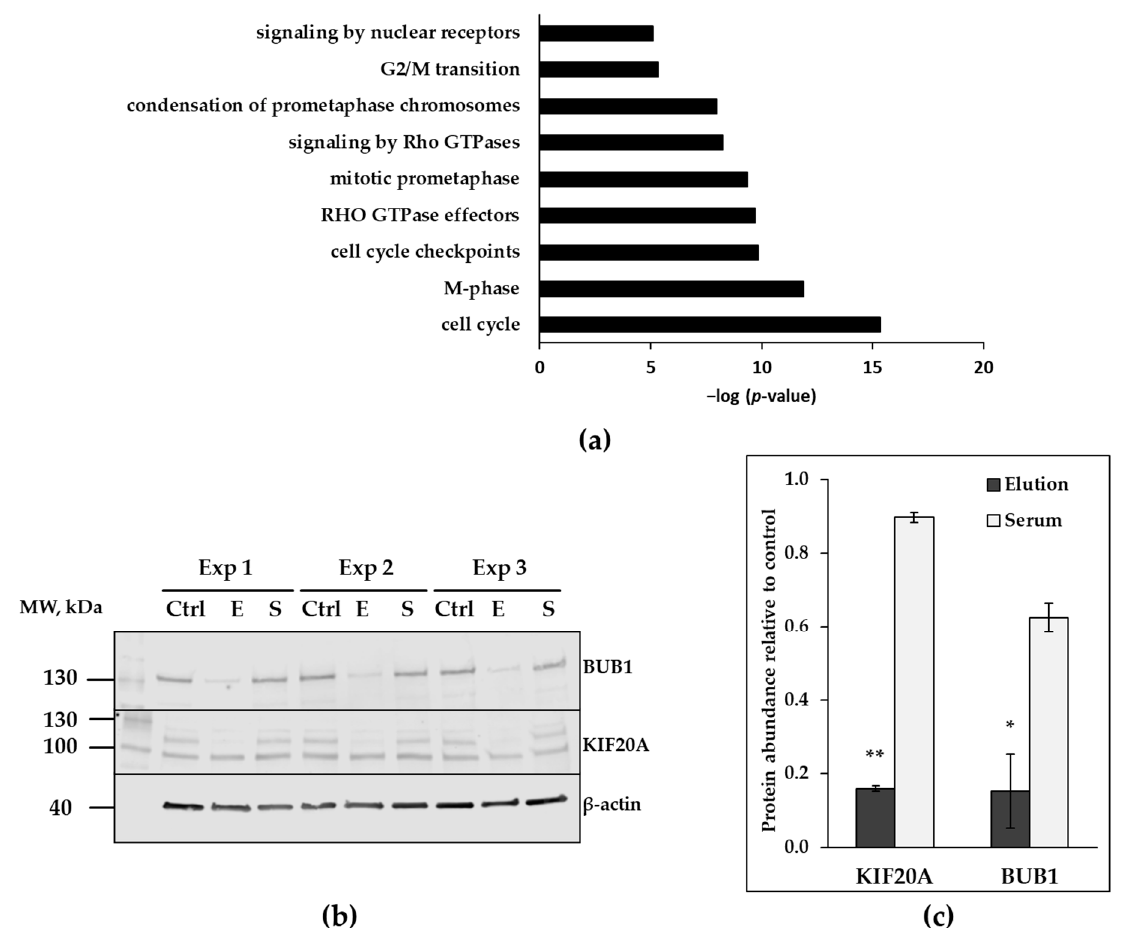
Figure 5. Targets involved into regulation of the cell cycle, down-regulated in HAECs after 24 h treatment with elution fraction. ( a ) Biological process categories overrepresented in 119 down-regulated genes in HAECs after 24 h treatment with eluted proteins (array data, n = 2). Significance generated with ConsensusPathDB-human (release 34, [26]) is presented on the x-axis as negative logarithmized p -value. ( b ) Validation of down-regulated protein targets with immunoblotting (n = 3). Proteins of interest were detected in cell lysates obtained from untreated HAECs (Ctrl), HAECs treated with 0.125 µg/mL of elution (E), 0.125 µg/mL of serum (S). Samples from three independent experiments are marked as Exp 1, Exp 2, Exp 3. KIF20A band is shown with the arrow. ( c ) Signal intensities from protein targets were normalized to signal intensity from β -actin, signals from treated cells are expressed as percent from untreated control. Data are presented as mean ± SEM. (* p ≤ 0.05; ** p ≤ 0.001).